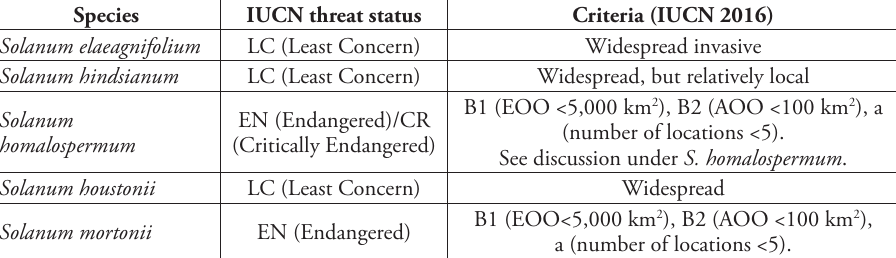
Table 3. Preliminary conservation status for members of the Elaeagnifolium clade. See Methods for details of threat status calculation, and species discussions for further